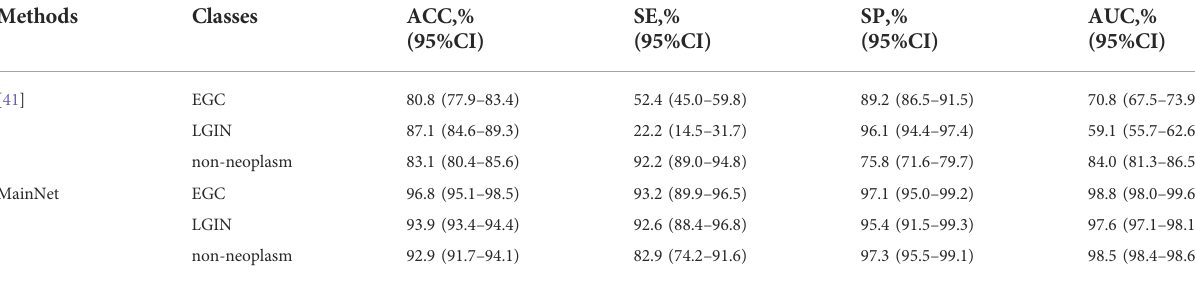
TABLE 5 Per-category average classi fi cation performance according to the 5-fold cross-validation.